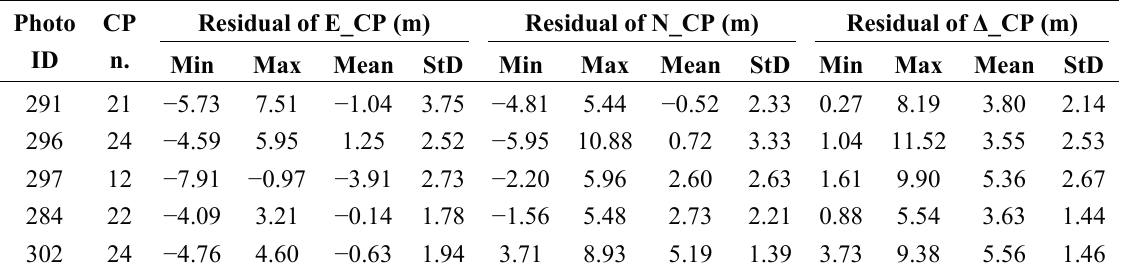
Table 4. Test 2—2006 lava flow in Valle del Bove (Mt Etna): statistics of CP residuals on the East ( E_CP) and North ( N_CP) components and on the computed displacements ( Δ _CP) : number of measured points (CP n.), minimum, maximum and mean values (Min, Max and Mean), standard deviations